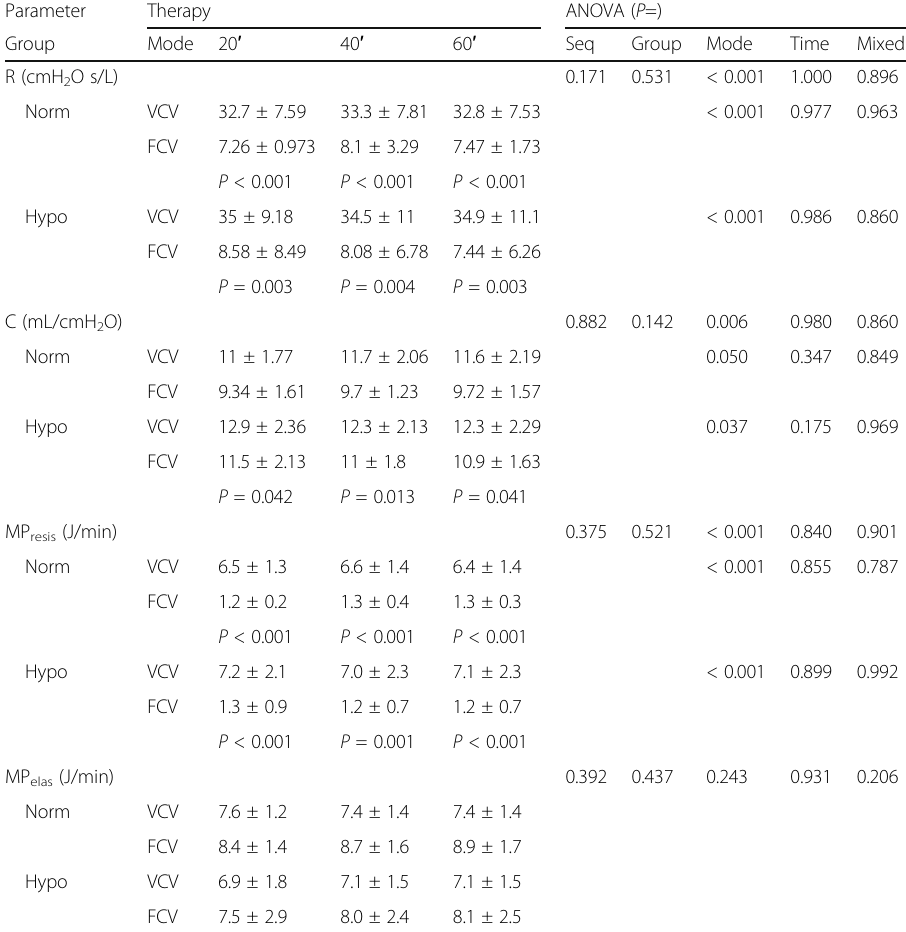
Table 3 Respiratory mechanics and mechanical